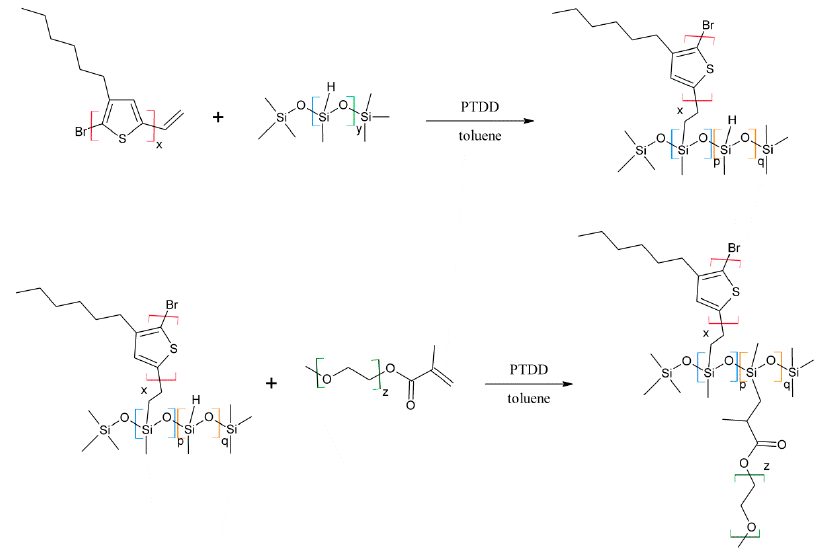
Scheme 3. Synthetic route to poly(methylhydrosiloxane)-graft-[poly(3-hexylthiophene); poly(ethylene glycol)]s (P3HT-Sil-PEGs).